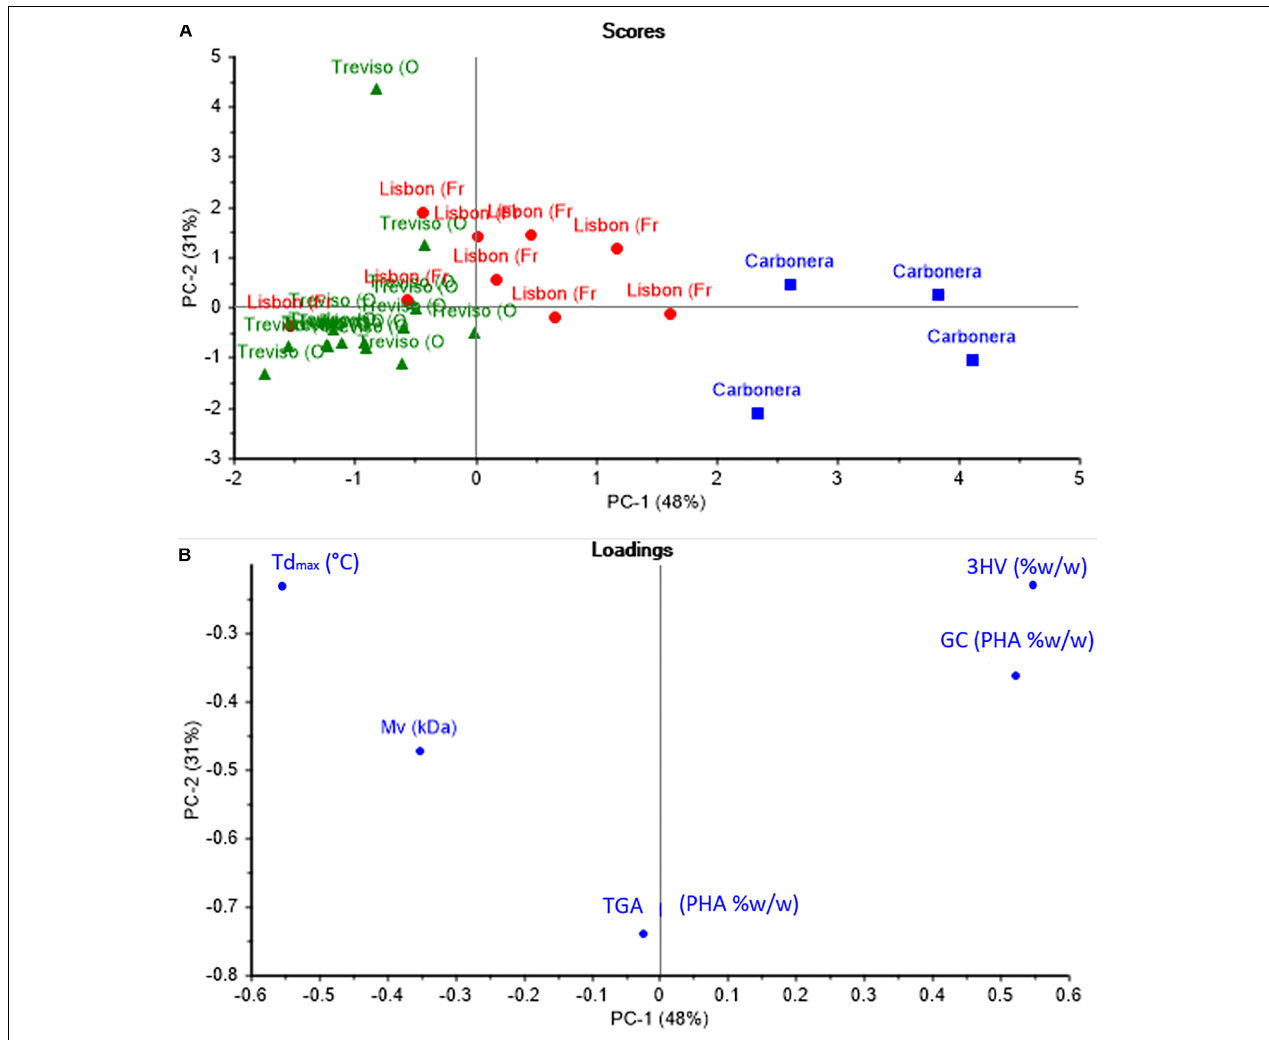
FIGURE 4 | Complete PCA. (A) Scores plot. (B) Loadings